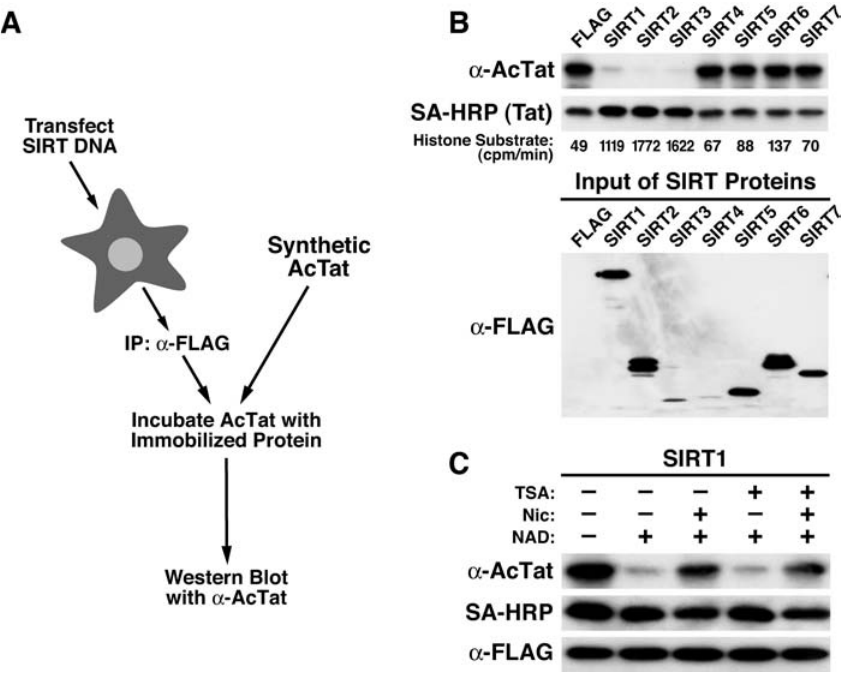
Figure 1. In Vitro Tat Deacetylation by Human SIRT Proteins (A) Scheme of Tat deacetylation assay with immunoprecipitated SIRT1–7 proteins. Expression vectors for FLAG-tagged SIRT proteins were transfected into HEK 293 cells, immunoprecipitated, and incubated with synthetic Tat (72 amino acids) carrying an N-terminal biotin label and an acetyl group at position 50 (AcTat) in the presence of NAD þ . Immunoprecipitated material was also analyzed in a radioactive ( 3 H) histone deacetylase assay using an H3 peptide as a substrate. (B) WB analysis of deacetylation reactions with antibodies specific for acetylated lysine 50 in Tat ( a -AcTat), with SA-HRP, or with a -FLAG antibodies. (C) WB of Tat deacetylation by immunoprecipitated SIRT1 in the presence or absence of NAD þ , TSA, or nicotinamide (Nic). DOI: 10.1371/journal.pbio.0030041.g001 PLoS Biology |